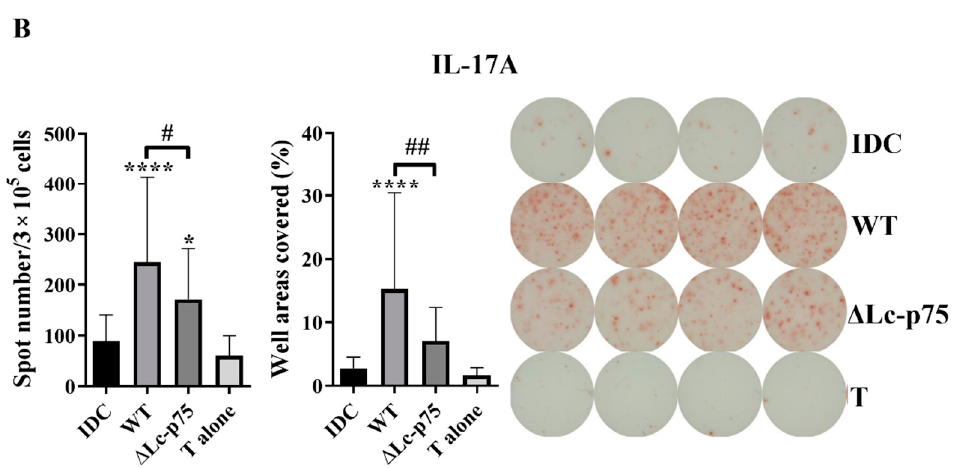
Figure 3. The T-cell-polarizing potential of moDCs is modulated by Lc-p75 inactivation in L. casei BL23. Five-day moDCs activated with wild-type (WT) and ∆ Lc-p75 mutant L. casei BL23 were washed and then cocultured with autologous T cells from freshly isolated PBLs at a ratio of 1:20 for 3 days. The frequency of cytokine-producing T lymphocytes was measured using IFN- γ ( A ) or IL- 17A ( B ) ELISPOT assays. The spot number was counted, or the area covered by the spots was cal- culated using a computer-assisted ELISPOT image analyzer. The mean value of spot numbers and well areas covered were calculated from 5 independent experiments with 4–6 parallel wells ±SD. One-way ANOVA followed by Tukey’s multiple-comparison test was used for statistical analysis.